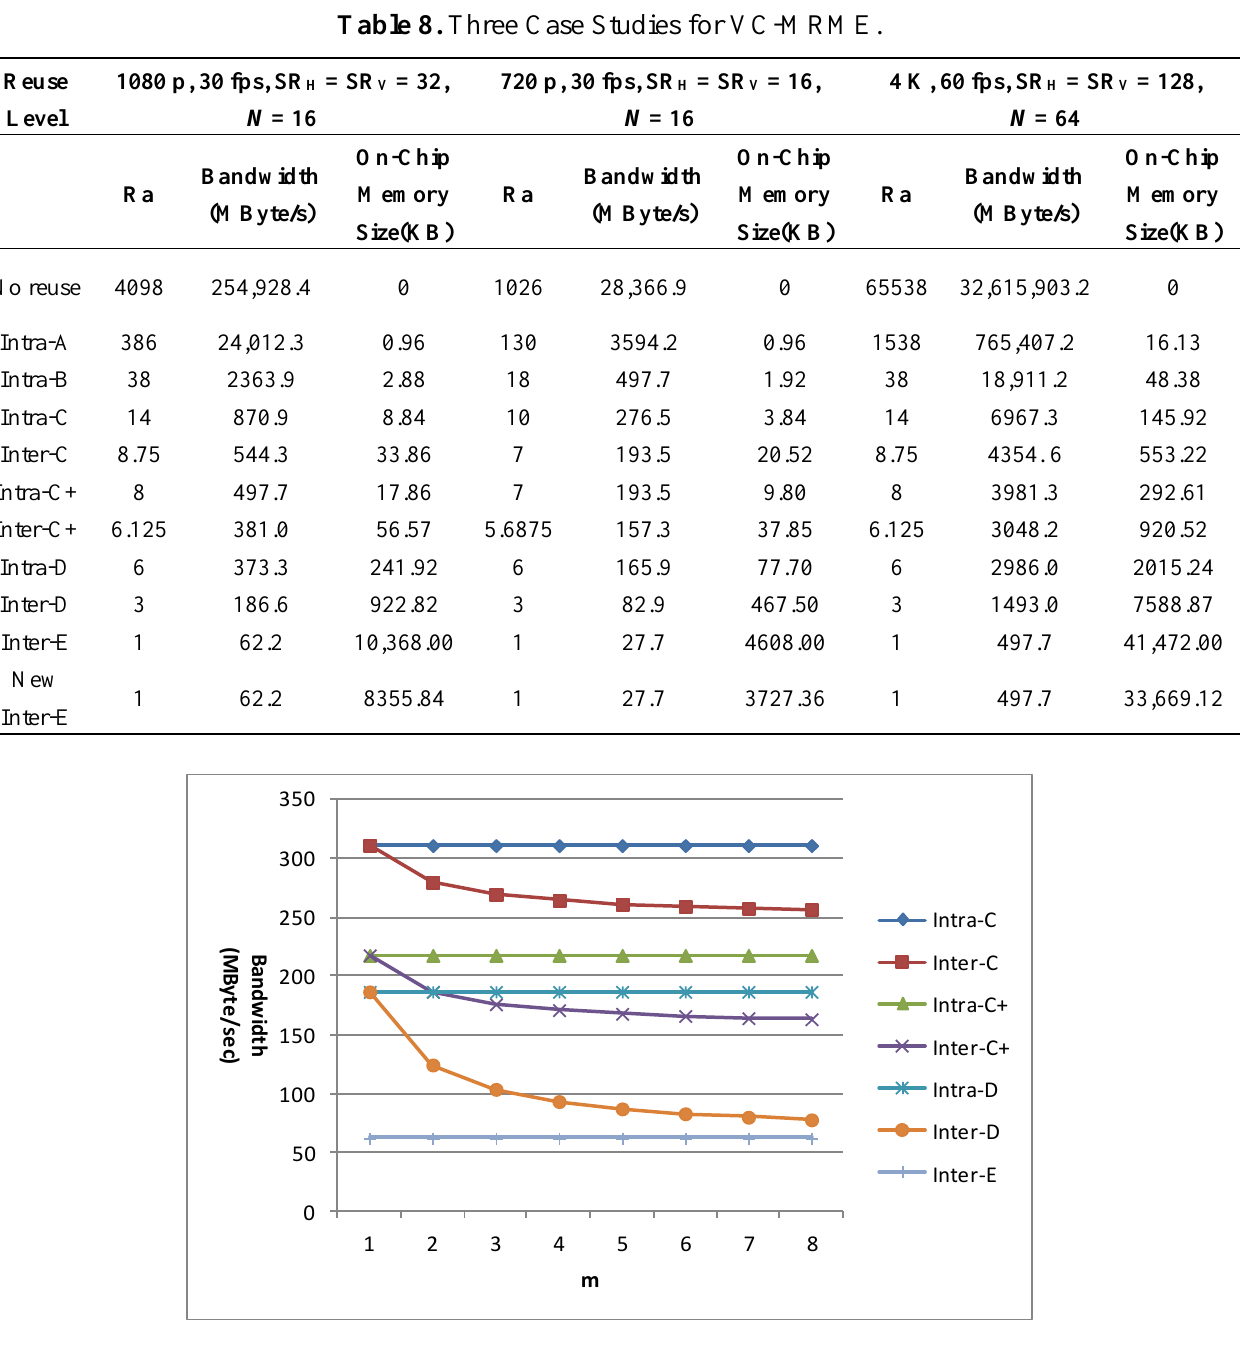
Figure 21. The bandwidth requirement of VC-SRME for 1080